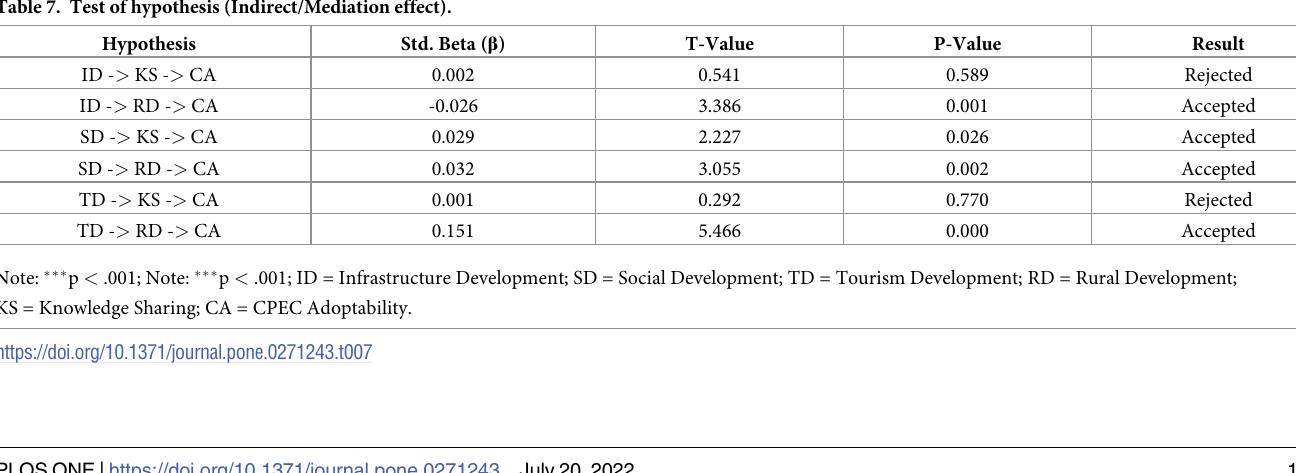
4.3.2 Indirect/Mediation effect. Results of indirect effects are shown in Table 7. The results show significant rural development mediation between infrastructural development and CPEC adoption ( β = -0.026, p < .001). In contrast, there is no mediation of knowledge sharing found between the relationship of infrastructural development and CPEC adoptability ( β = 0.02, p > .05), and tourism development and CPEC adoptability ( β = 0.001, p > .05). Fur- thermore, the results show significant mediation of knowledge sharing between the relation- ship of social development and CPEC adoptability ( β = 0.029, p < .001) and significant mediation of rural development between social development and CPEC adoptability ( β = 0.032, p < .001), and tourism development and CPEC adoptability ( β = 0.151, p < .001). These results are also presented in Figs 3 and 4.